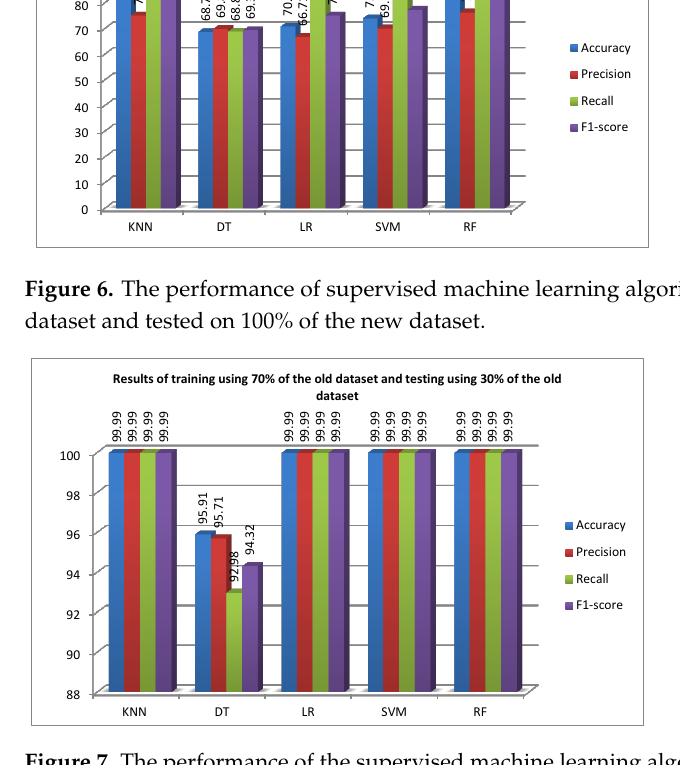
Figure 7. The performance of the supervised machine learning algorithms trained on 70% of the old dataset and tested on 30% of the old dataset.